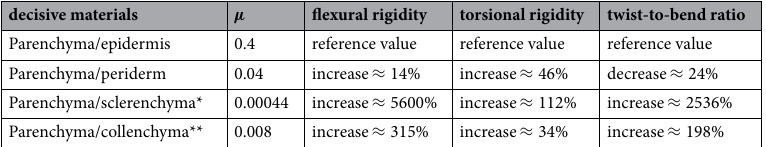
Table 3. Summary of the simulation results. The mechanical effect of various changes of the structural reinforcement is given as a percentage increase or decrease with reference to the initial configuration (= reference value). Figure 2a shows the initial configuration in terms of a triangular cross-section comprising of parenchyma with embedded vascular bundles surrounded by an epidermis. µ is the ratio of estimated elastic moduli ( E est ) of the decisive materials (see Table 2). The percentage values inherent to the fibre reinforcements are computed with respect to the optimal number of fibre strands. namely, *49 sclerenchyma strands and **24 collenchyma strands (see Figs. 4,